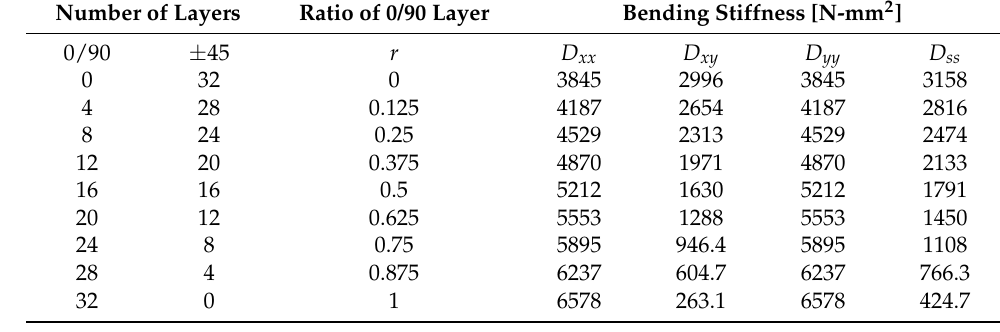
Table 3. Layup Table 3. Layup sequence.